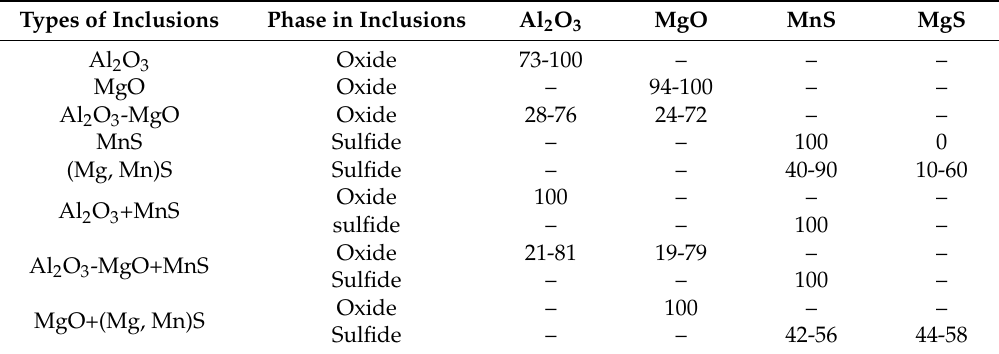
Table 3. Composition ranges of different types of inclusions (mass pct.).